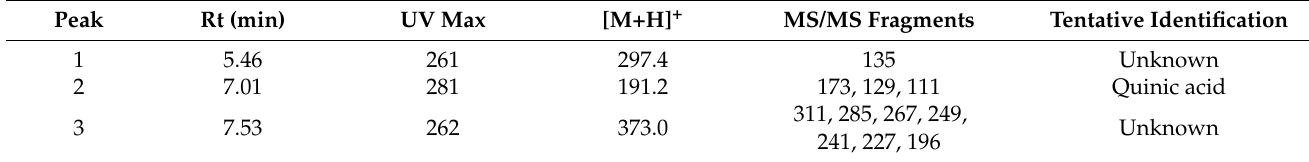
Figure 1. Chromatogram (registered at 280 nm) obtained in the analysis of phenolic compounds of pinguica ( E. tinifolia ). Table 2. Tentative identification of phenolic compounds of E. tinifolia fruit extract, determined by HPLC-DAD-MS/MS.